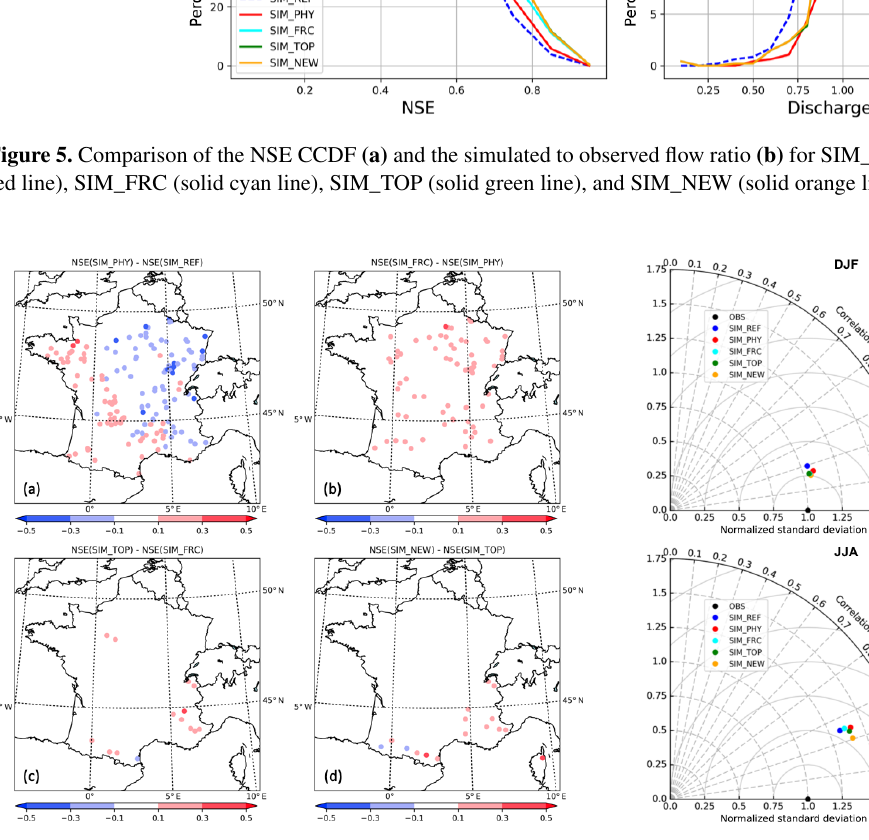
Figure 8. Taylor diagrams of seasonal river flows for the different experiments over the period 1958–2018.